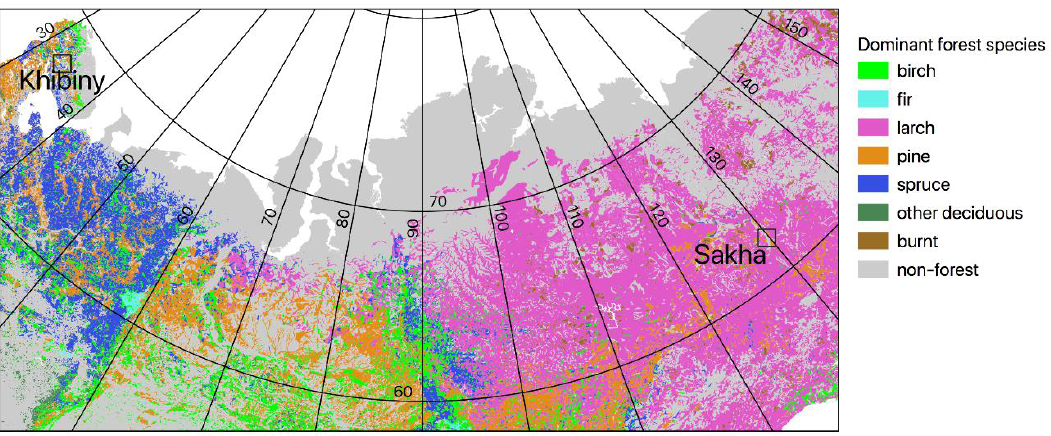
Figure 2. Location of study areas within the Russian boreal forest. Background map shows dominant forest types and is simplified from [67] using original data from [68]. Map prepared by the authors.